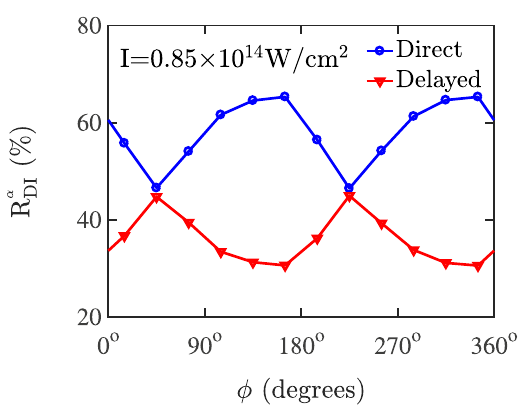
Figure 11. Percentage contribution of the direct and the delayed pathways of double ionization as a function of the CEP at an intensity of 0.85 × 10 14 W/cm 2